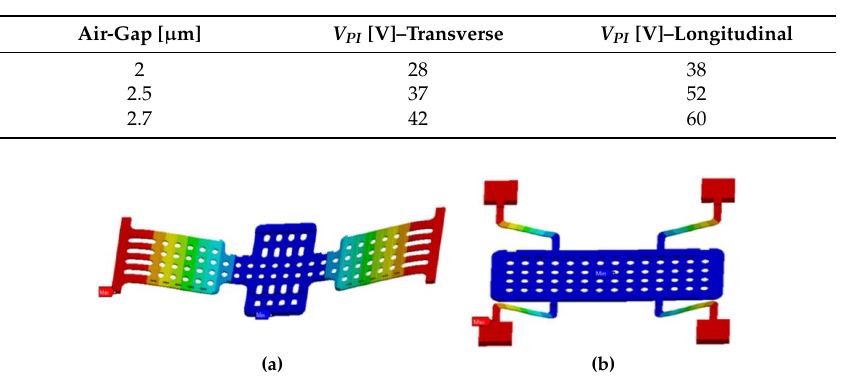
Figure 3. Electromechanical simulated results for the transverse ( a ) and longitudinal ( b ) RF-MEMS membrane geometries with 2 µm air-gap. The color scale indicates the membrane deformation. The RF performance of the phase shifters employing the just discussed micro-relays is simulated by means of Finite Element Method (FEM) analysis. Figures 4 and 5 show the reflection (S11), insertion loss (S21), and phase delay for several configurations of the K and Ka band phase shifters, respectively. The simulated losses at 19.5 GHz are better than −2 dB in a 2 GHz frequency span, while reflection is between −40 and −25 dB at the center frequency (K band phase shifter; see Figure 4).